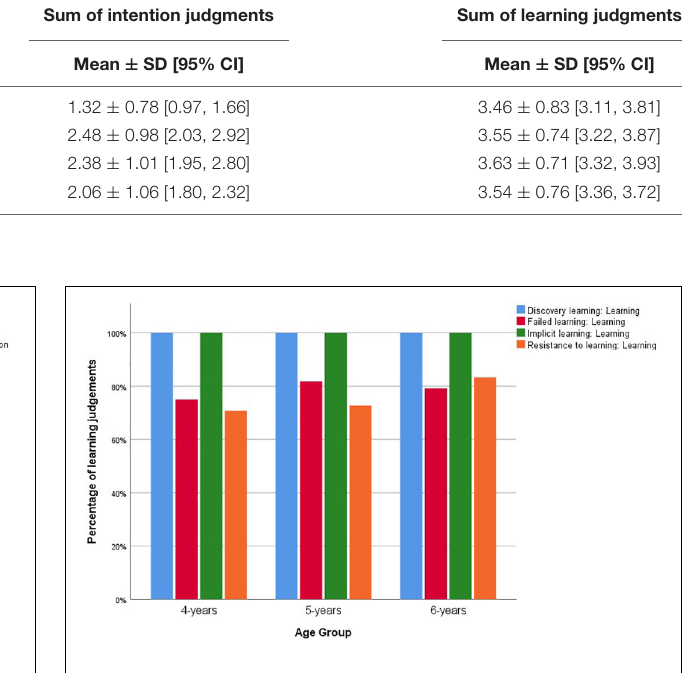
FIGURE 2 | Children’s intention judgments in study 2 across age groups. FIGURE 3 | Children’s learning judgments in study 2 across age